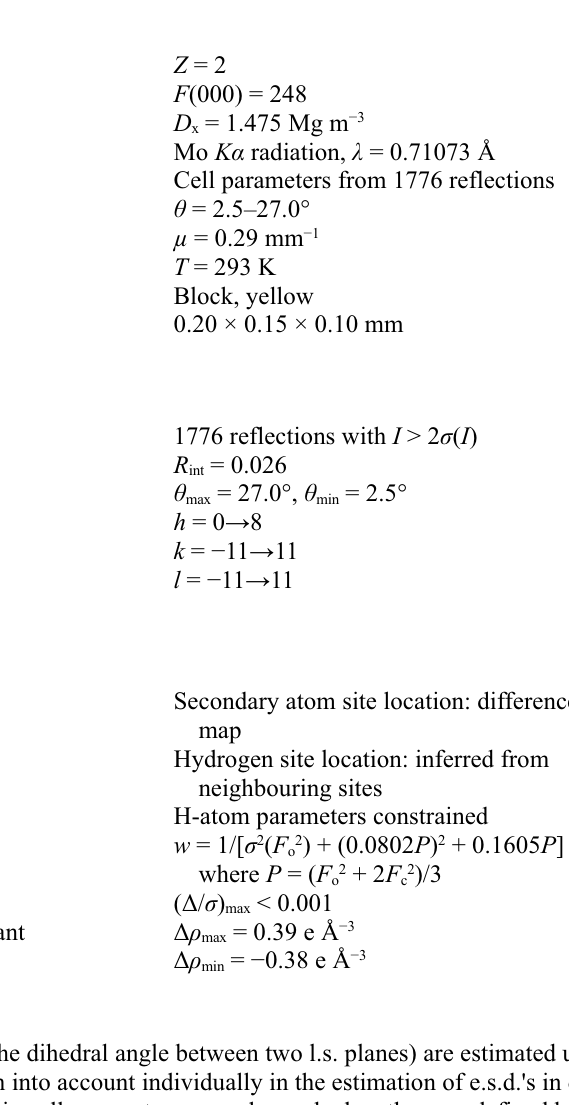
Figure 1 The structure of the title compound showing 30% probability displacement ellipsoids and the atom-numbering scheme.